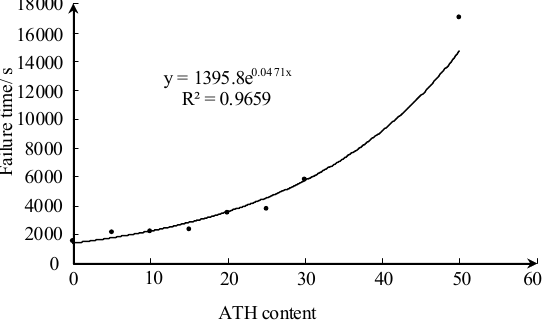
Figure 3. Failure time of IPT for different samples with different ATH contents under 3.5 kV test conditions.